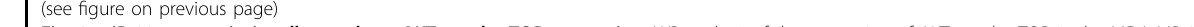
Fig. 2 miR-99s transcriptionally regulates AKT1 and mTOR expression. WB analysis of the expression of AKT1 and mTOR in the MDA-MB-231 cells treated with Comp34 (100nM), MG132 (1 mM), or their combination for 24 h. b Bioinformatics prediction of miR-99s binding site1 and site2 at two distinct positions in human AKT1 3 ′ -UTRs by TargetScan. c A schematic representation of luciferase reporter of WT or consecutive mutation of AKT1 constructs containing the 5 ’ -UTR and CDS of luciferase, predicted targeting sequences and the corresponding mutants cloned into the 3 ’ -UTR of luciferase. UTR Untranslated Region, CDS Coding Sequence. d miR-99s reduce the luciferase activity of wild-type (WT) instead of the mutated AKT 1 3 ’ -UTR. Data are presented as relative luciferase activity of fi re fl y luciferase activity to renilla luciferase activity ( n = 3). * P < 0.05 versus control; ** P < 0.01 versus control. e Predicted miR-99s binding site in human mTOR 3 ’ -UTR. f A schematic representation of luciferase reporter of WT or consecutive mutation of mTOR constructs. g miR-99s reduce the luciferase activity of WT instead of the mutated mTOR 3 ’ -UTR. Data are presented as relative luciferase activity of fi re fl y luciferase activity to renilla luciferase activity ( n = 3). *** P < 0.001 versus control. h , i The effect of the miR-99s on the mRNA and protein expression of AKT1 and mTOR. MDA-MB-231 cells were transfected with miR-99s mimics or negative control. Real-time PCR and Western blot analysis were performed to measure the mRNA ( h ) and protein ( i ) levels of AKT1 and mTOR, respectively. * P < 0.05 versus control; ** P < 0.01 versus control. Heatmaps representing the top 30 downregulated genes associated with overexpression of miR-99a ( j ), miR-99b ( k ), and miR-100 ( l ) in MDA-MB-231